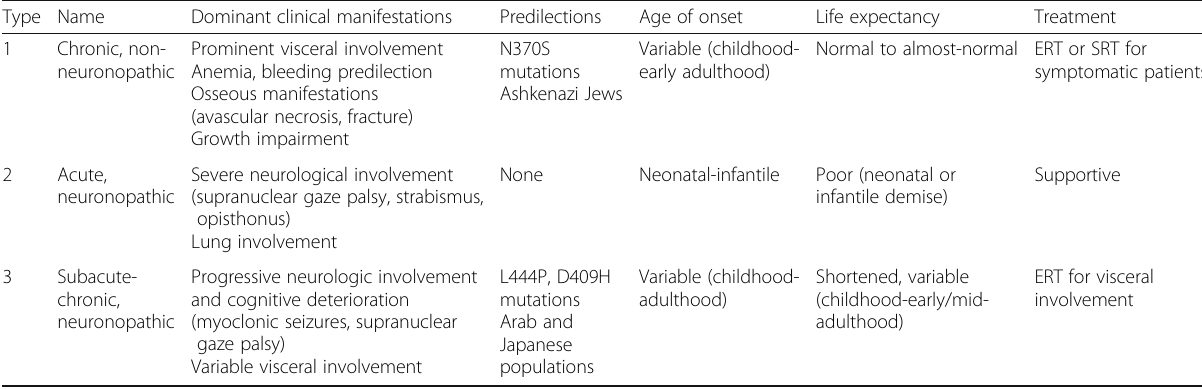
Table 1 Clinical classifications of Gaucher